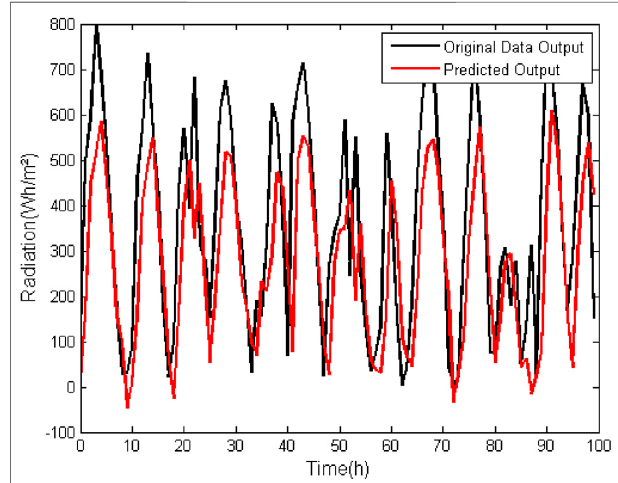
FIGURE 6 | ARX model (na = 4, nb = 4, nk = 1) for prediction of normal direct radiation data with suppression of